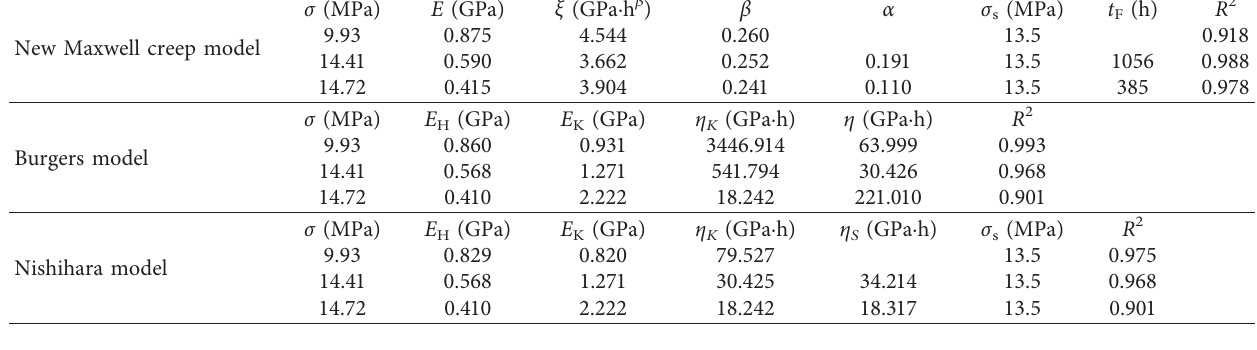
Table 1: Parameters determined through fitting analysis based on creep tests of rock salt.